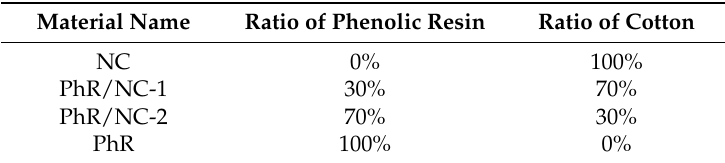
Table 1. Sample denomination and ratio content of phenolic resin and cotton